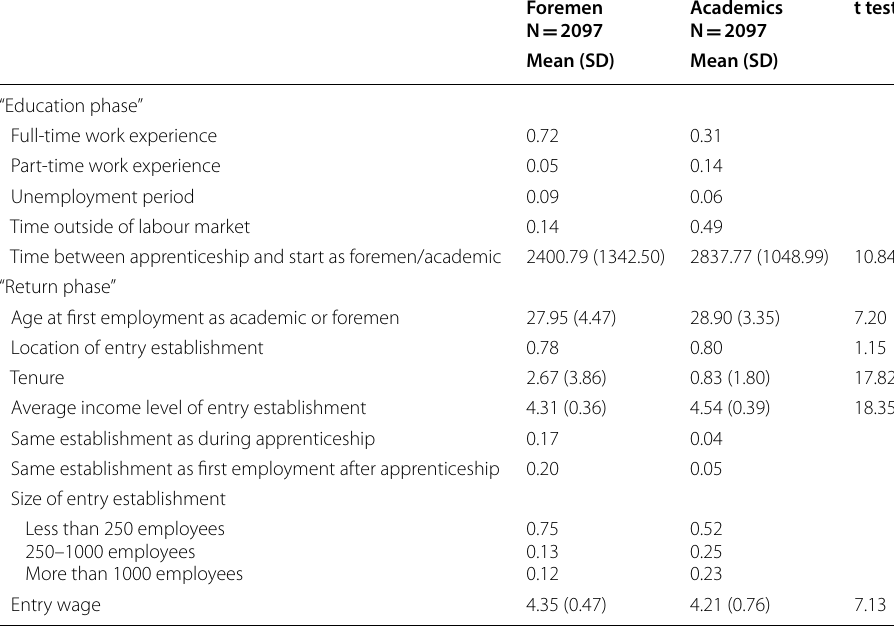
Table 3 Descriptive statistics after